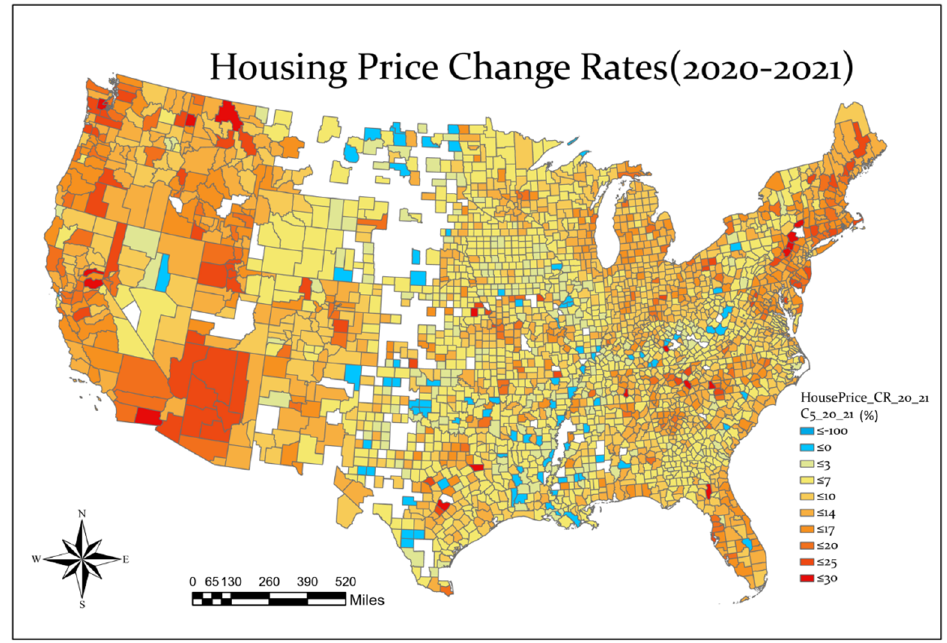
Figure 3. Housing price change rates during the pandemic year of 2020–2021 (from 1 May 2020 to 1 May 2021).